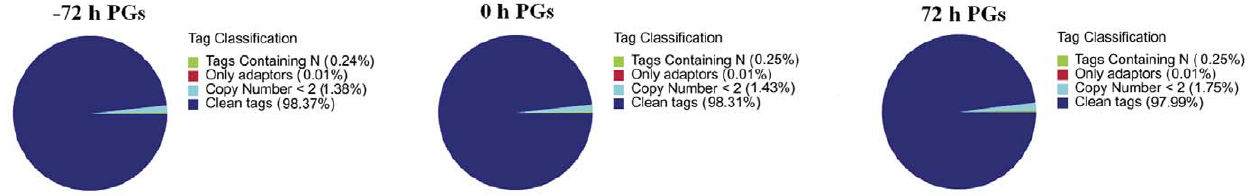
Figure 1. Different components of the raw tags in each sample. The percentages of clean tags, raw tags containing N, empty tags with adaptor only, and tags with copy number , 2.